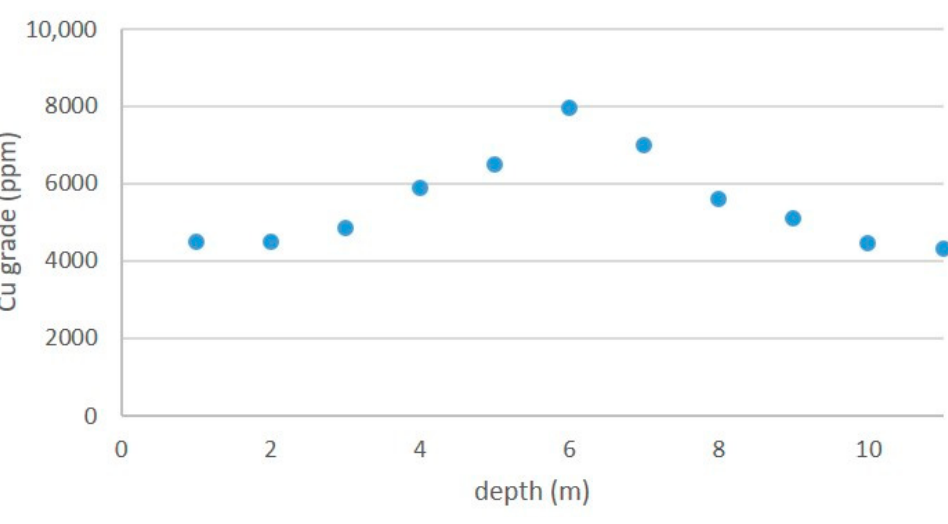
Figure 4. Average Cu grade by depth for all available samples (18 from 0–4 m and only 3 samples from 7–11 m).